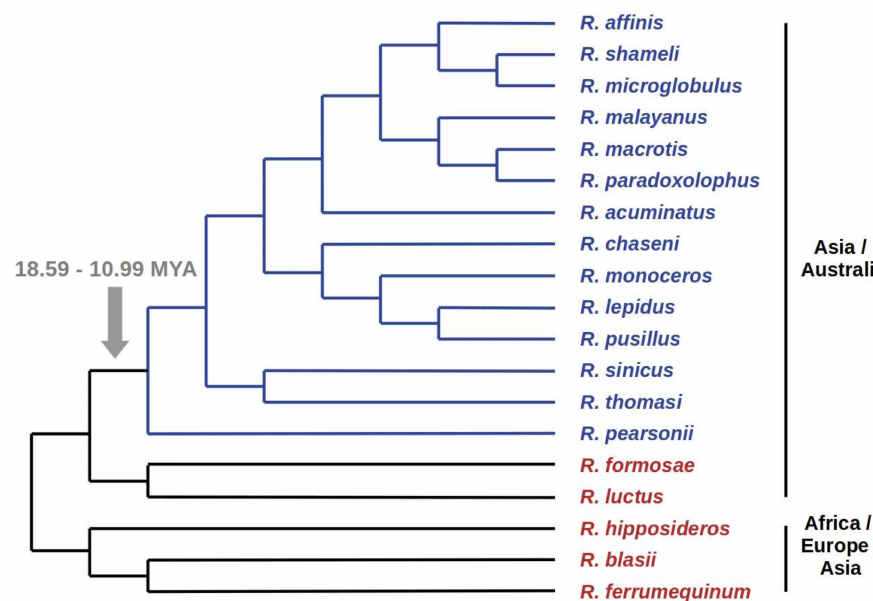
Figure 2. The presence of ChirDelta2 in various species of rhinolophid bats. The results of PCR-based screening of selected Rhinolophus DNA samples are shown in a consensus species cladogram. Species that tested positive for ChirDelta2 sequence are in blue, species that tested negative are in red. The monophyletic group, comprising the positive species (marked by blue branches), defines the branch where integration of ChirDelta2 probably occurred. Time estimates for nodes surrounding this branch are shown. Geographical distributions of the species are indicated on the right side.